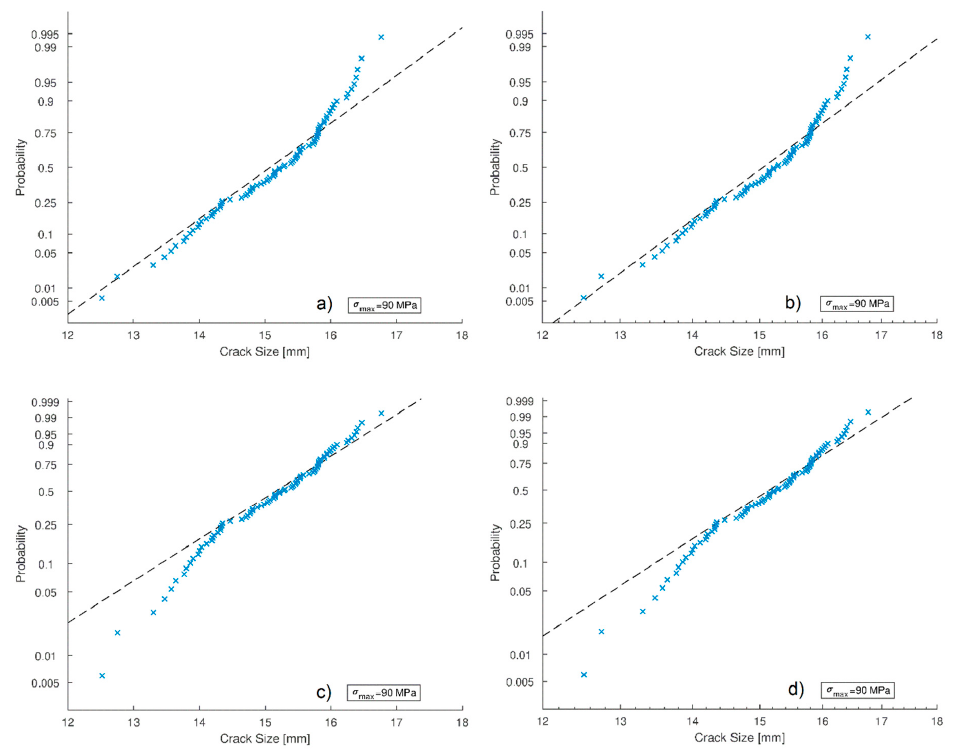
Figure 11. Critical crack size at 90 MPa: probability plots for normal ( a ), log-normal ( b ), extreme value ( c ) and Weibull ( d ) distributions.